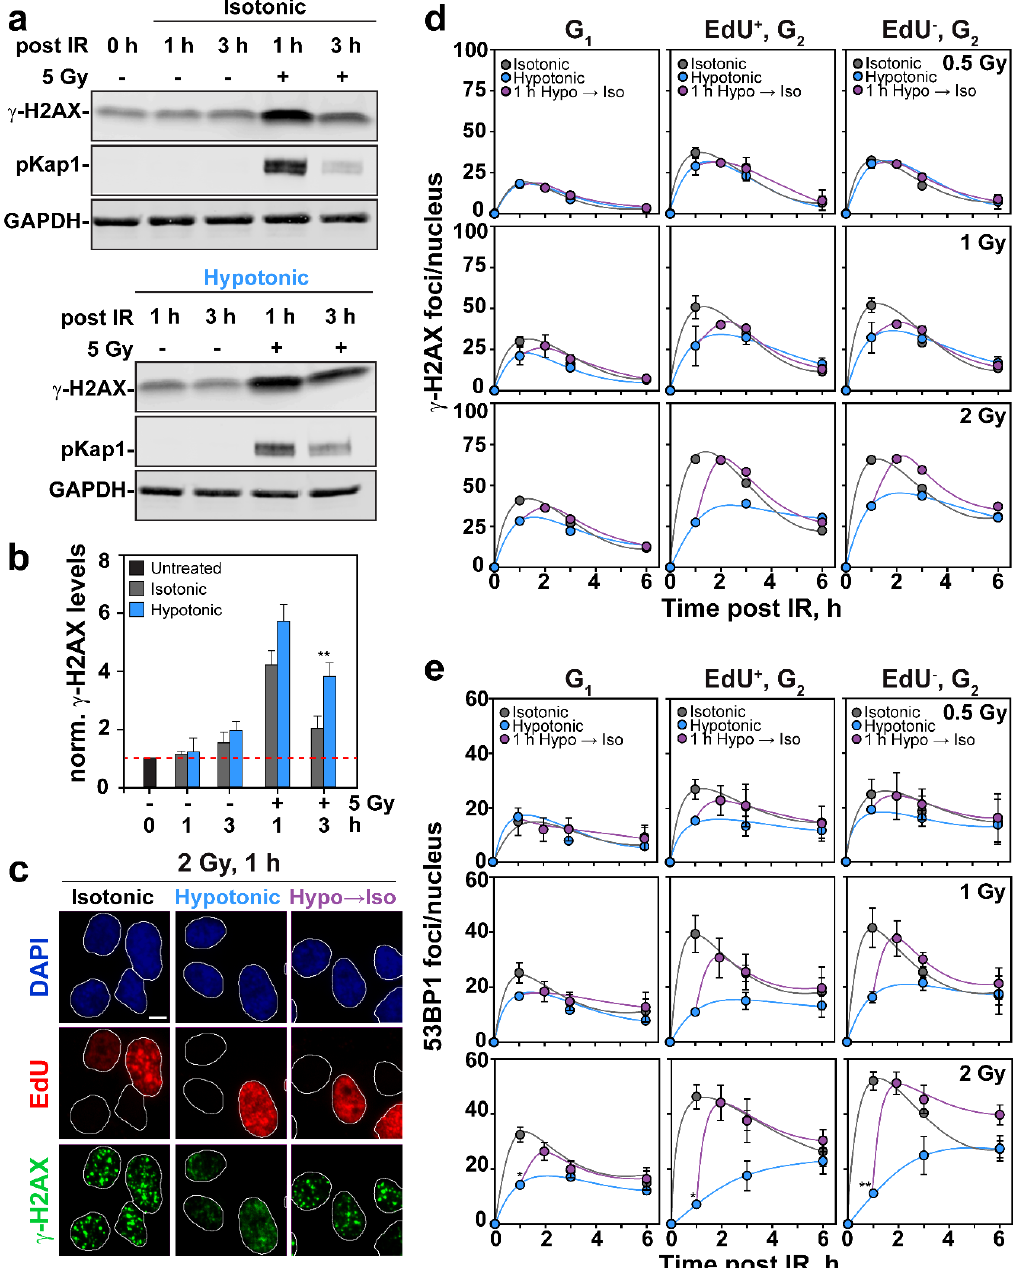
Figure 4. HypoS suppresses formation of γ -H2AX and 53BP1 foci in an IR-dose and cell cycle phase-dependent manner. ( a ) Western blot analysis of γ -H2AX and pKap1 in extracts of RPE cells as a function of time after exposure to HypoS and 5 Gy. GAPDH served as loading control. ( b ) Densitometric analysis of γ -H2AX band intensity in a. Plotted is protein level normalized to loading control. Means ± SE from two independent experiments are shown. ( c ) Representative images of DAPI-stained RPE nuclei showing EdU incorporation and γ -H2AX foci formation after 1 h of HypoS and 2 Gy. Images of cells transiently (1 h) exposed to hypotonic medium are also shown. Scale bar: 5 µm. ( d ) QIBC analysis of γ -H2AX foci formation after background (nonirradiated) subtraction in G 1 -phase cells, EdU + , G 2 -phase cells and EdU − , G 2 -phase cells maintained in isotonic (grey symbols) or hypotonic medium (blue symbols) after exposure to the indicated IR doses. Violet symbols show kinetics of foci formation in cells that were treated hypotonically post IR for 1 h and then transferred to isotonic medium. Data represents means ± SE from two experiments (except for 2 Gy where n = 1). Error bars are visible when larger than the symbols used. ( e ) As in ( d ) for 53BP1. Differences reaching statistical significance between isotonic and hypotonic treated cells are marked with * p < 0.05 and ** p <